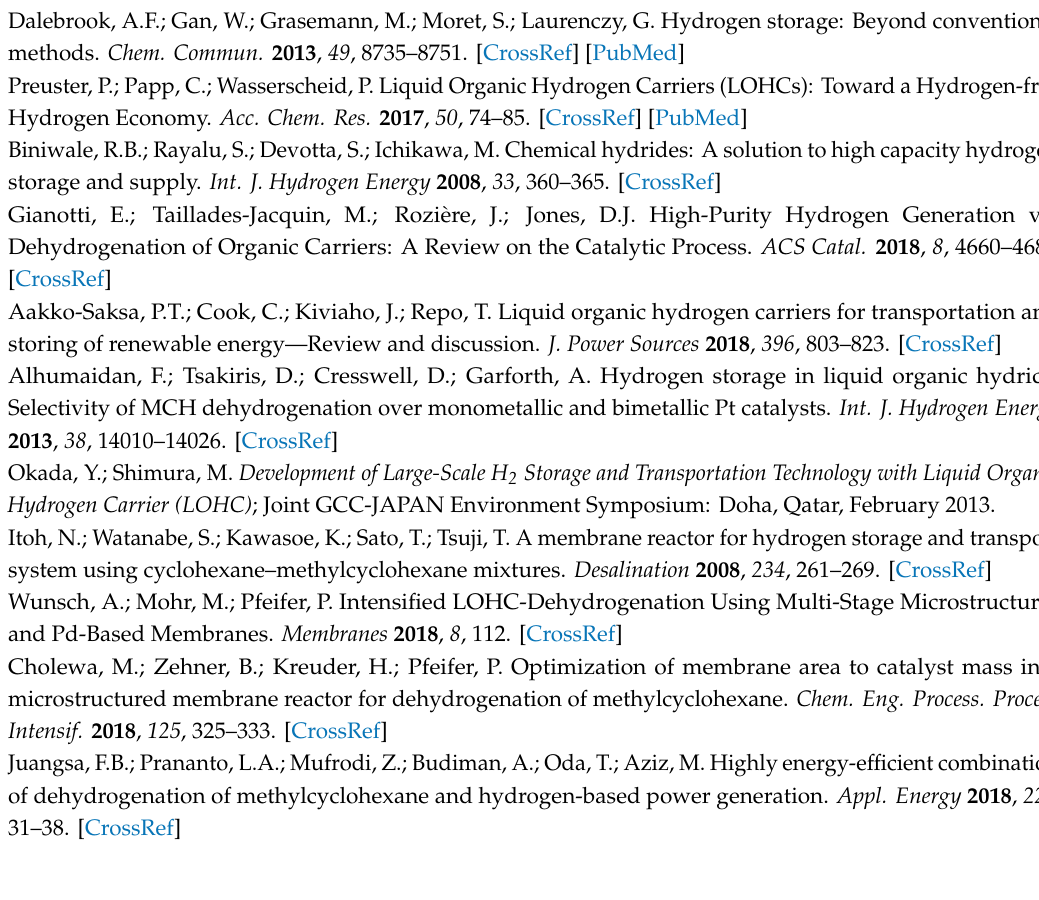
Figure S1: HRTEM images and corresponding EDX data (nickel and copper atomic percentages) for the catalysts after reduction at 400 ◦ C and passivation, Figure S2: Dependence of toluene yield on copper fraction (wt%) in the pCu catalysts and SG_Ni-SiO 2 at di ff erent temperatures in the methylcyclohexane dehydrogenation. Copper fraction is a percentage of copper relative to the total amount of both metals (nickel and copper), Table S1: Phase composition and average size of coherent scattering region (CSD size, Å) for the catalysts in oxidized